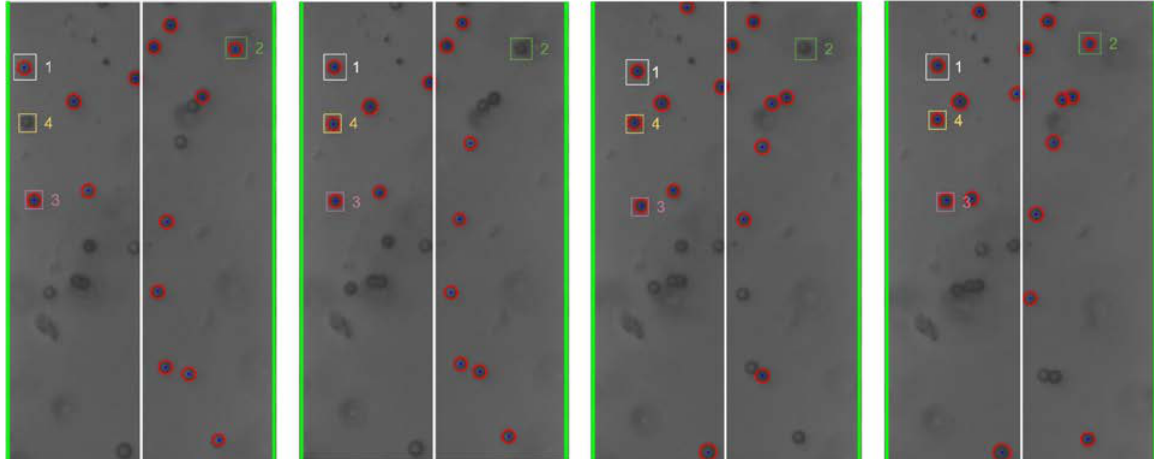
Figure 10. Individual bead movement during Trial 2 from frames 570 to 685.